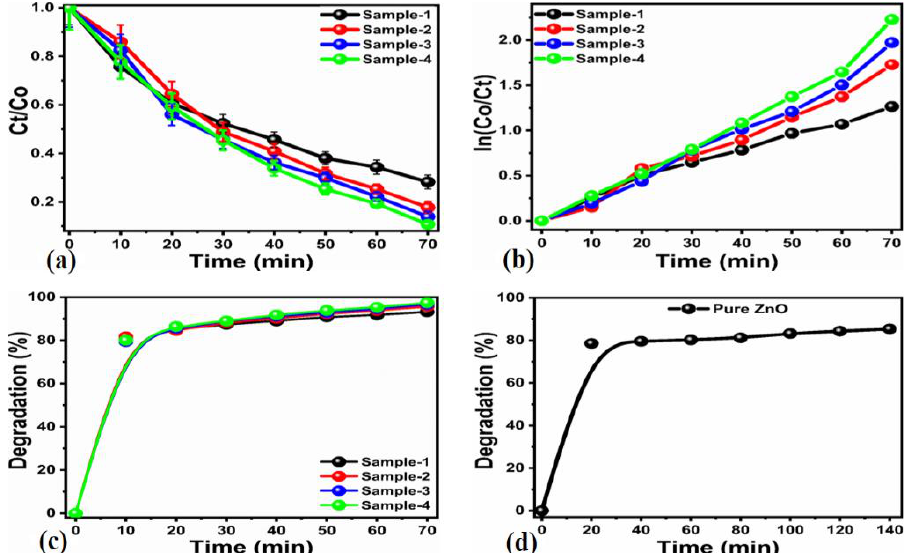
Figure 12. Degradation kinetics ( a ) kinetics C t / C o irradiation time, ( b ) Ln C t / C o plot, ( c ) percent degradation of MG, ( d ) degradation percentage of pure ZnO over MG.